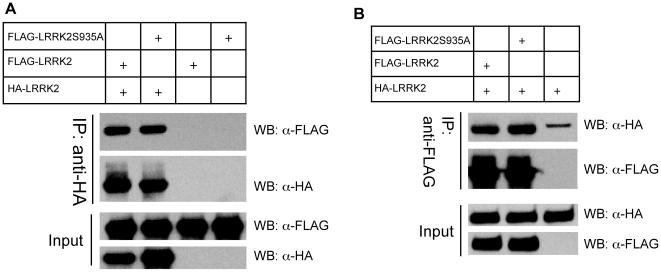
S935A mutation does not affect LRRK2 dimerization.(A, B) FLAG-LRRK2 WT or S935A mutant construct was co-transfected with HA-LRRK2 constructs. The Co-IP assay was performed using either anti-HA (A) or anti-FLAG (B) antibody, followed by Western blot analysis using the indicated antibodies.